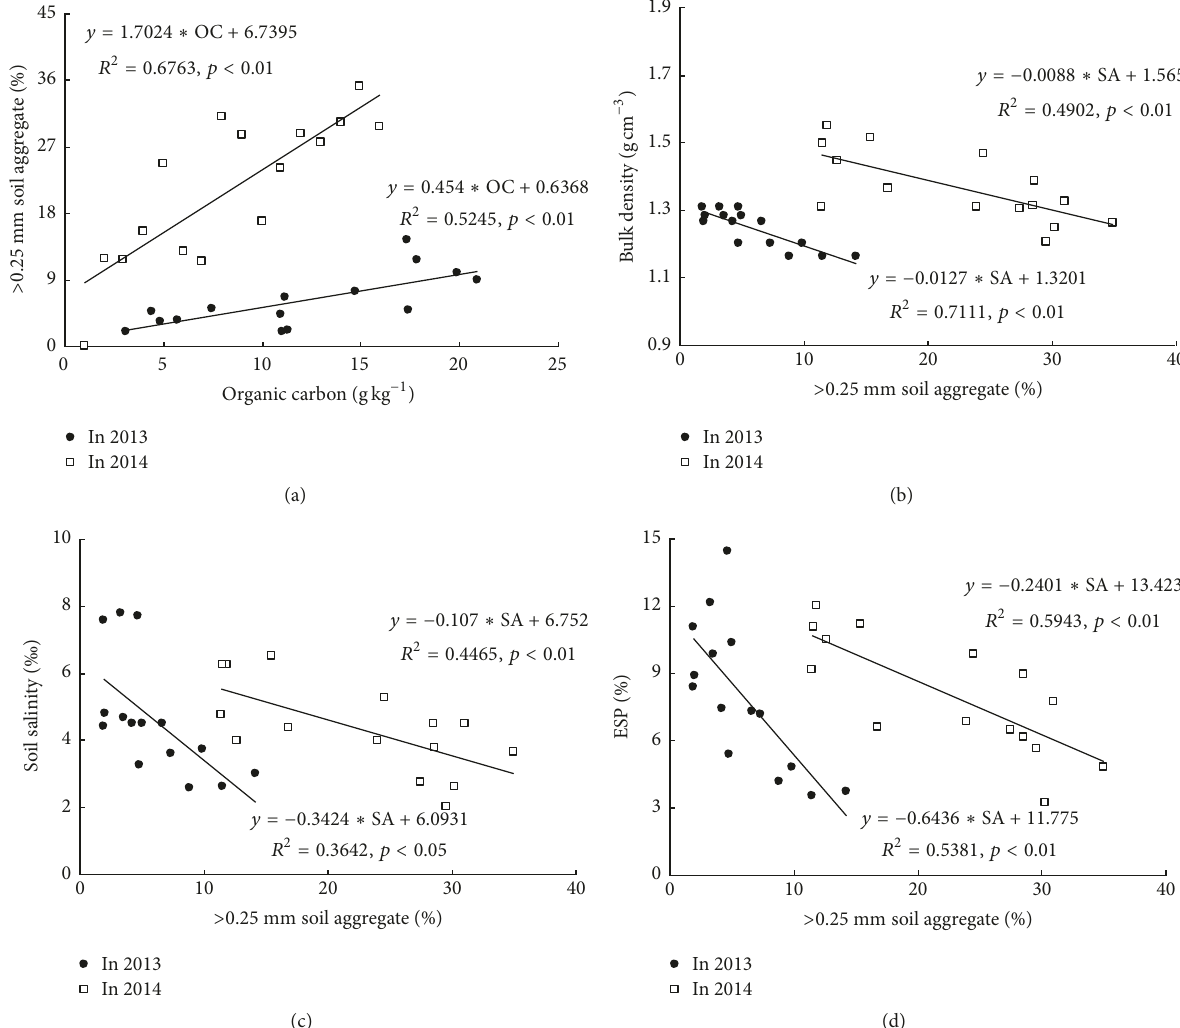
Figure 6: Relationships between percentage of > 0.25 mm soil water-stable aggregate (SA) and organic carbon (a), bulk density (b), salinity (c), and ESP (d) in the mudflat